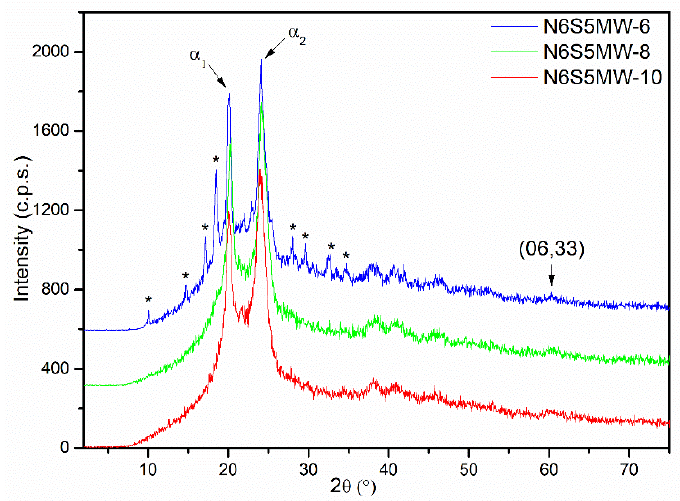
Figure 8. PXRD diagrams of samples N6S5MW-6, N6S5MW-8, and N6S5MW-10 (* peaks due to Ԑ – ε caprolactam).